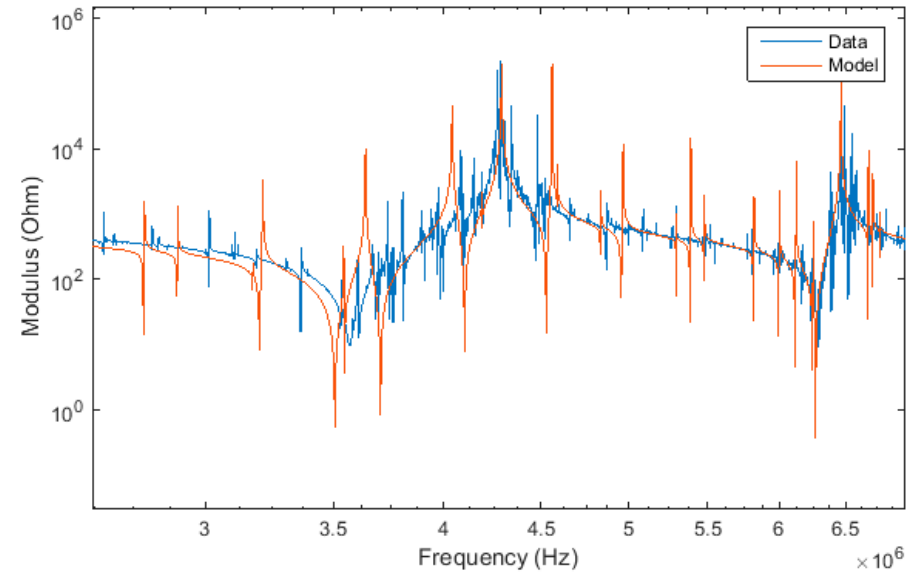
Figure 3. Impedance modulus spectrum of Y-cut LiNbO 3 around the shear and the thickness resonance.